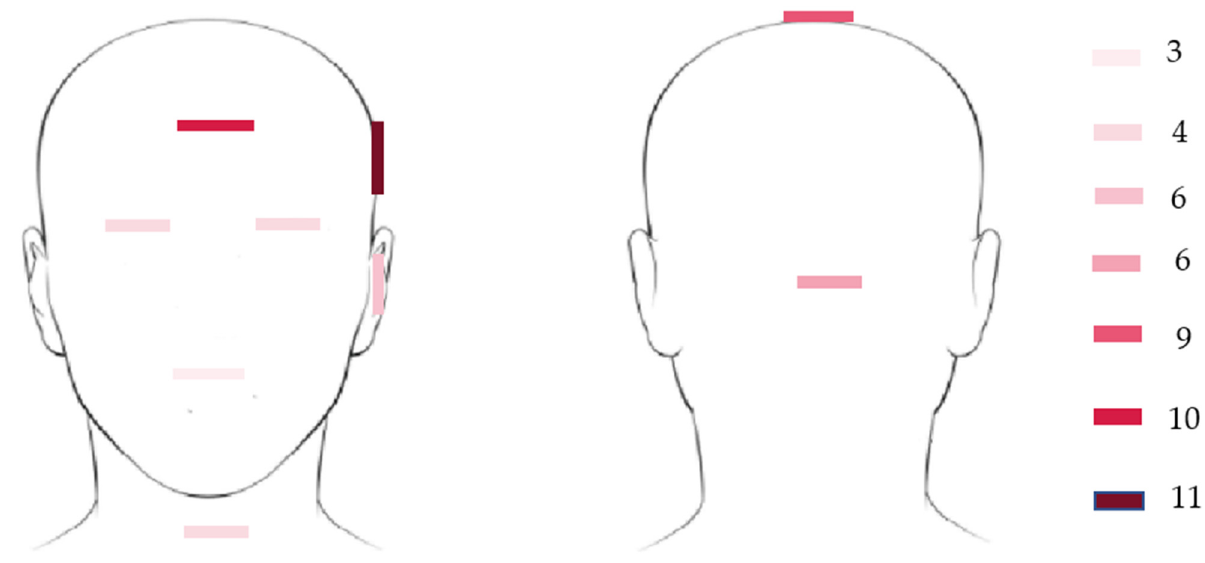
Figure 5. Distribution of inertial sensors on the head.